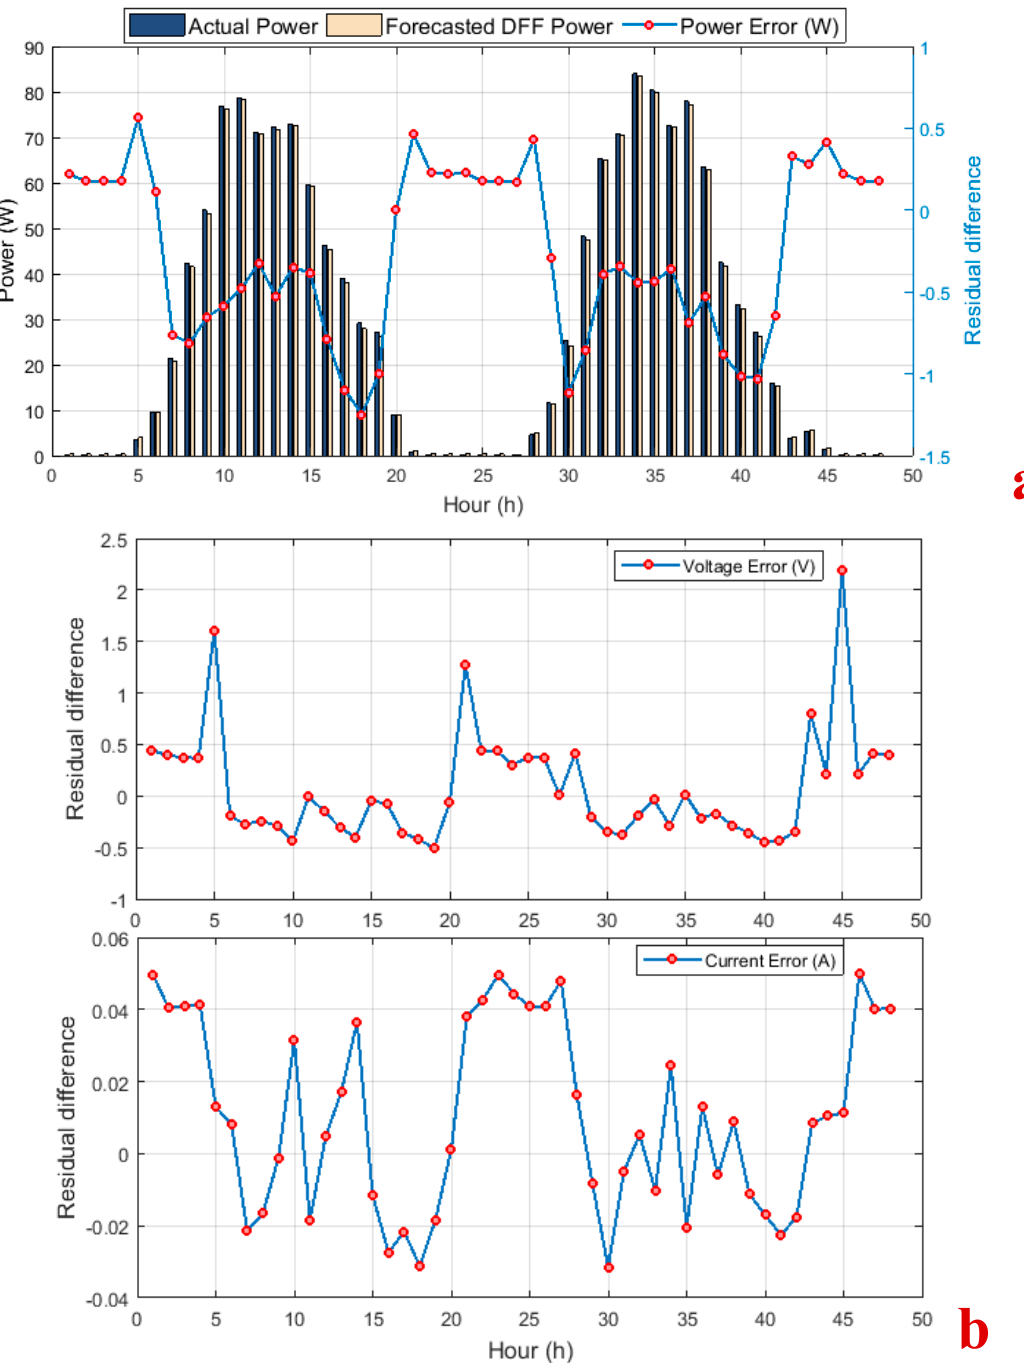
Figure 10. Real time comparison using Sharp’s-NUS0E3E PV panel ( a ) between the actual power and simulated DFF network ( b ) DFF voltage and current errors.